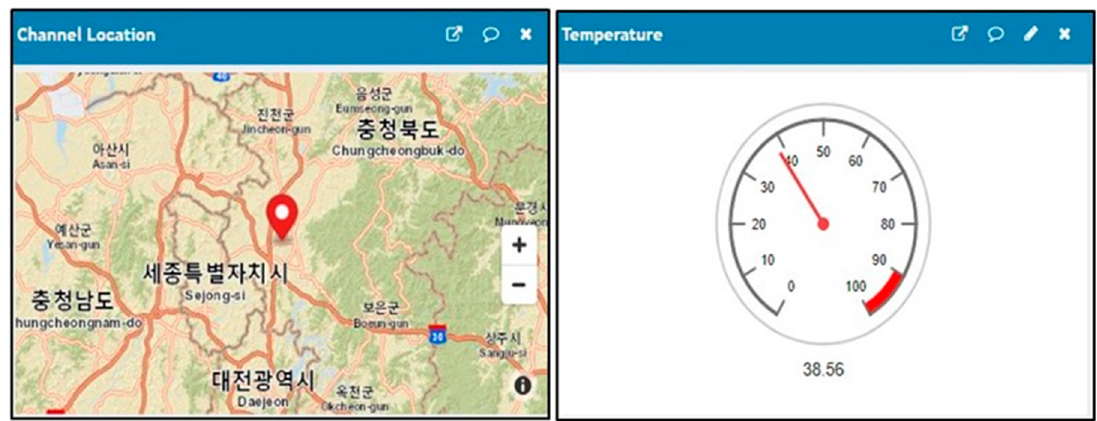
Figure A5. GPS and body temperature sensor data visualization on ThingSpeak cloud.